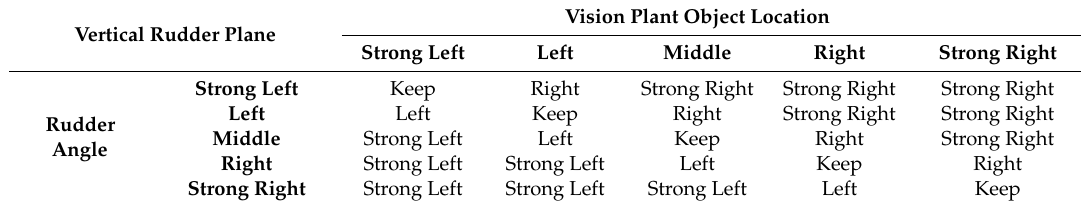
Table 2. Rules for the vertical rudder plane.